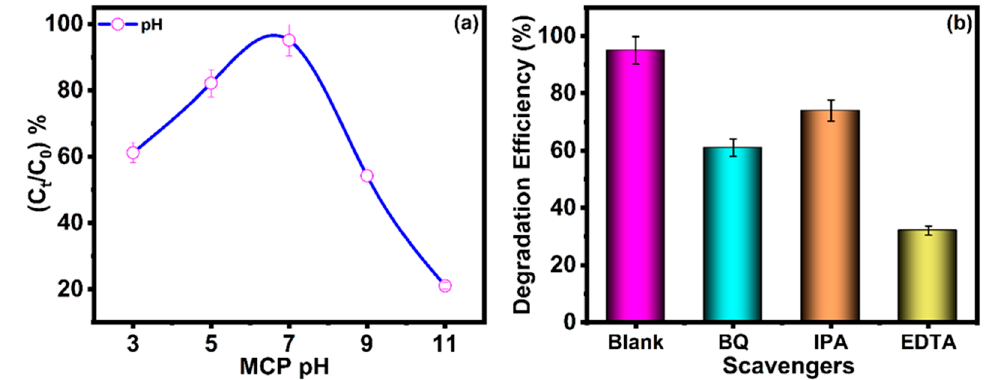
Figure 10. ( a ) Effect of pH and ( b ) effect of radical scavengers .